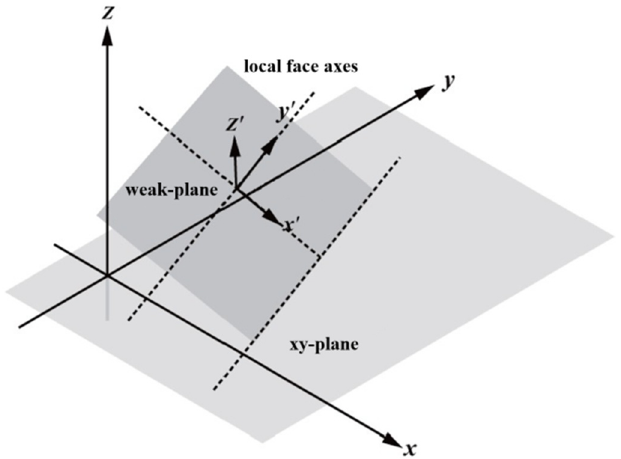
Figure 4. The relationship between the global coordinate system and the local coordinate system of the joint plane.